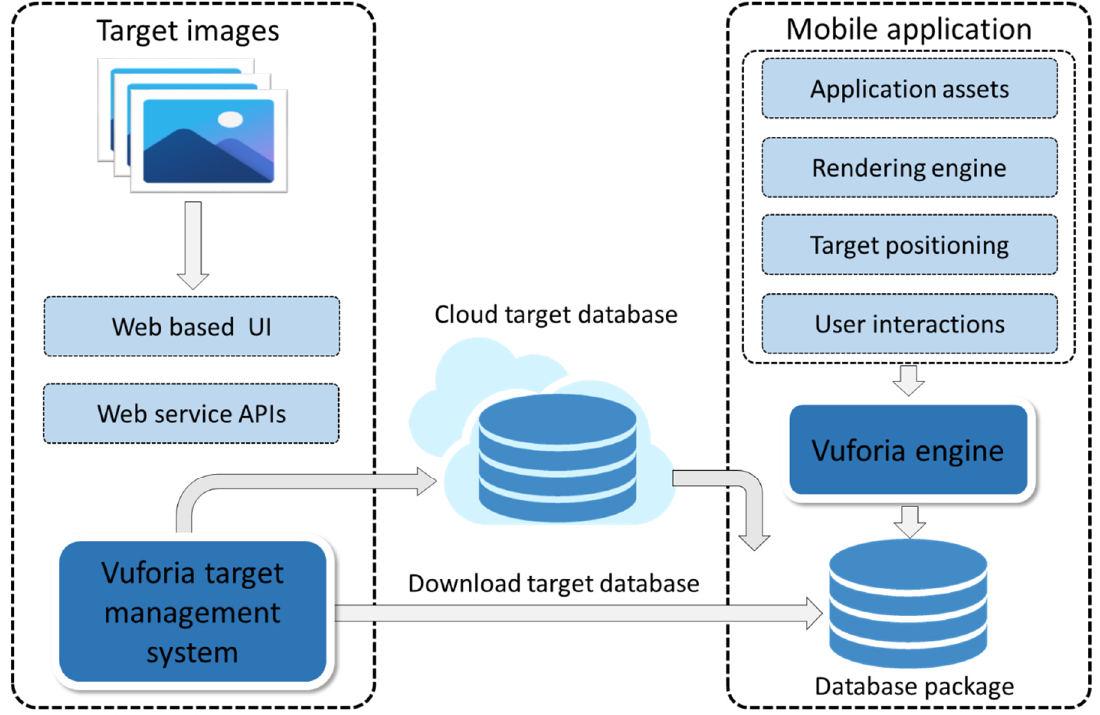
Figure 1. The complete architecture of the Vuforia software development kit. This Vuforia platform consists of a Vuforia engine and a web-based Vuforia target management system where the target images are uploaded. The cloud target databases are accessed directly using web services, while the device-based database is downloaded from the developer portal.